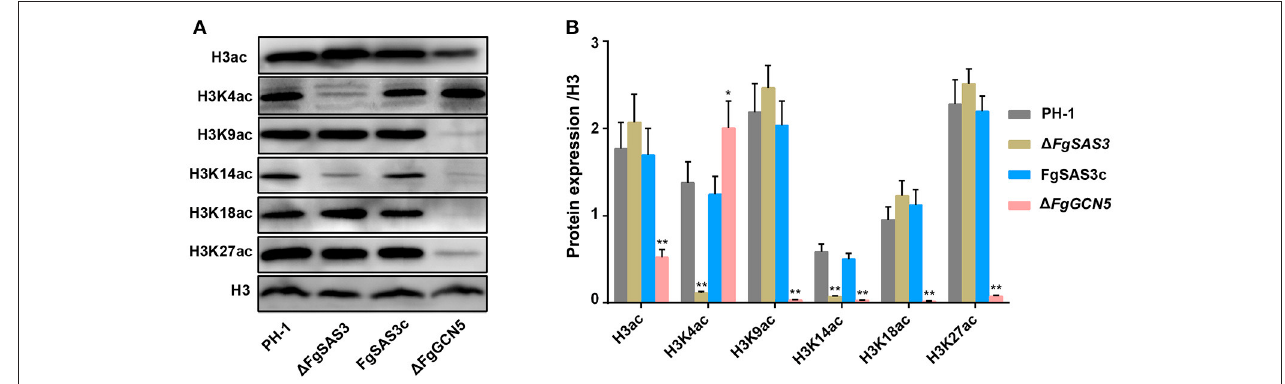
FIGURE 5 | Western blotting analysis of proteins that extracted from PH-1, 1 FgSAS3 , FgSAS3c, and 1 FgGCN5 , respectively. (A) The respective strains were grown for 3 days in liquid TBI medium. The antibody anti-acetyl histone 3 (H3ac), anti-acetyl H3K4 (H3K4ac), anti-acetyl H3K9 (H3K9ac), anti-acetyl H3K14 (H3K14ac), anti-acetyl H3K18 (H3K18ac), and anti-acetyl H3K927(H3K27ac) were used for detection of alterations of acetylation levels. Antibody H3 was used as a loading reference. (B) Quantification of western blot signals in the three replicates. Data were expressed as mean IOD (relative to H3) ± standard error. * P < 0.05, ** P <